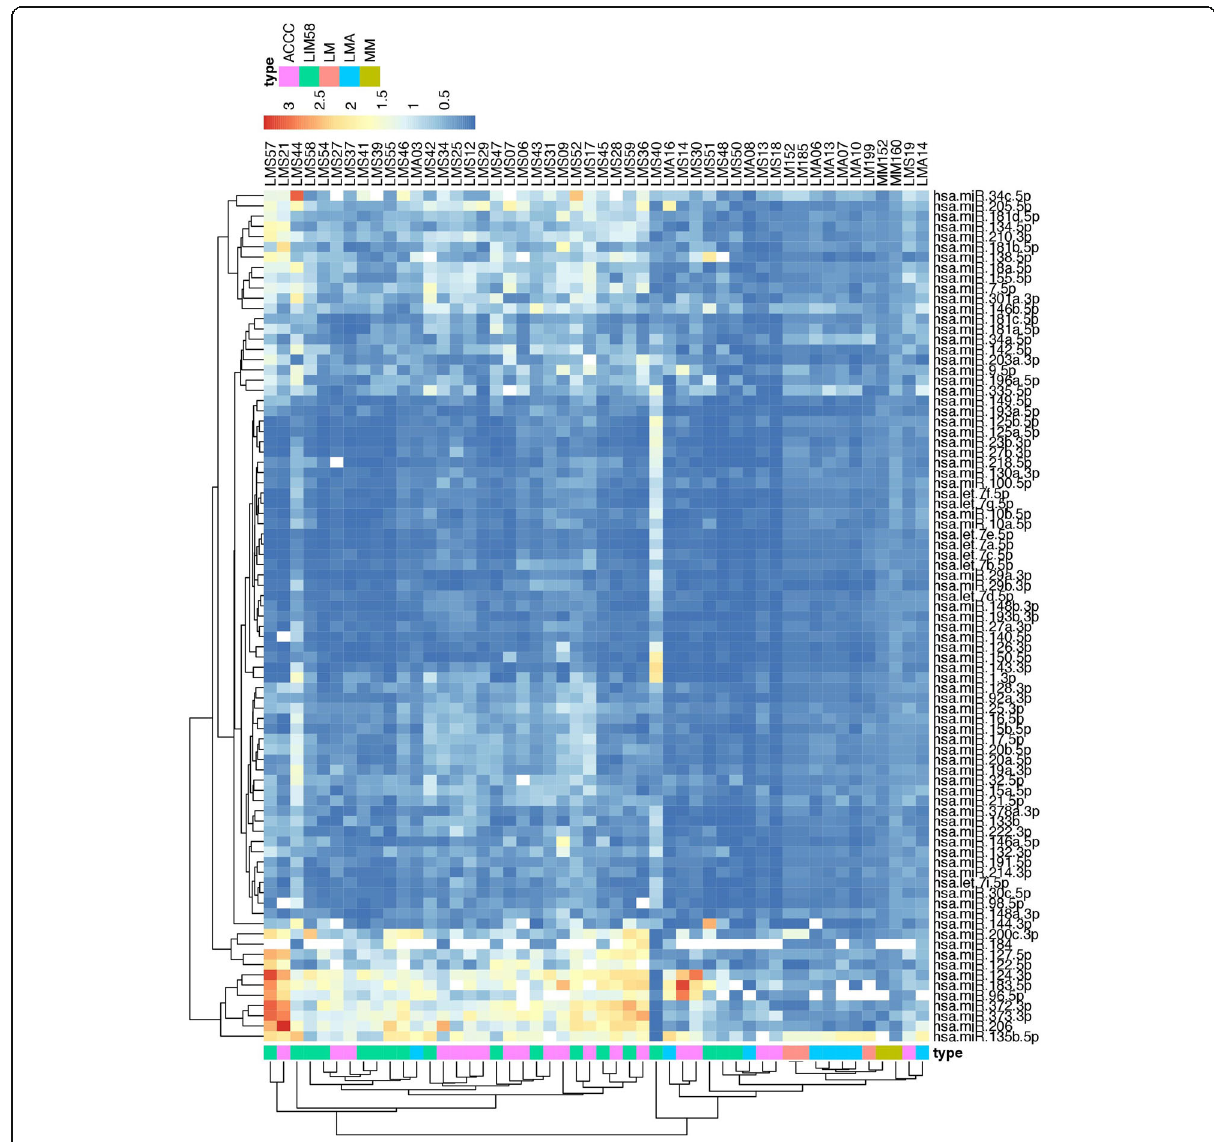
Fig. 1 Hierarchical clustering of miRNAs according to tissue. In this heatmap, hierarchical data of miRNA expression profiling in LM, ULM, and LMS tumors are represented, with MM samples used as a normal reference. Blue coloring indicates miRNAs that are downregulated and red coloring indicates miRNAs that are upregulated. Type color bar indicates institutional origin of the LMS samples (purple: ACCC – A.C.Camargo Cancer Center; green: LIM58 – Hospital das Clinicas da Universidade de Sao Paulo) and histological classification of non-malignant tissues (LM - red color, LMA - blue and MM –